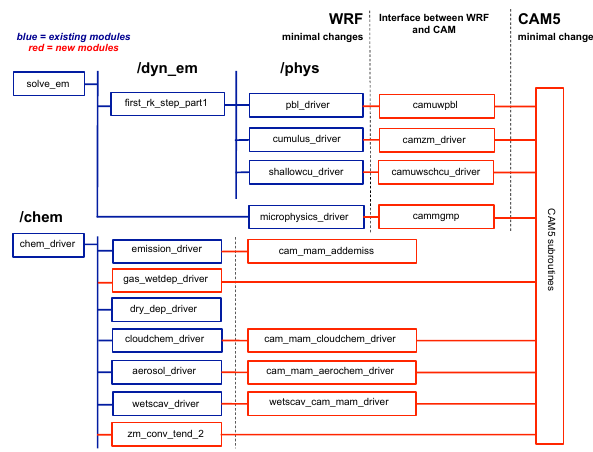
Fig. 2. Partial flow chart of the code implementation of the CAM5 physics suite within the WRF model, where blue denotes exist- ing WRF modules and red denotes modules associated with CAM5 physics and their interfaces with